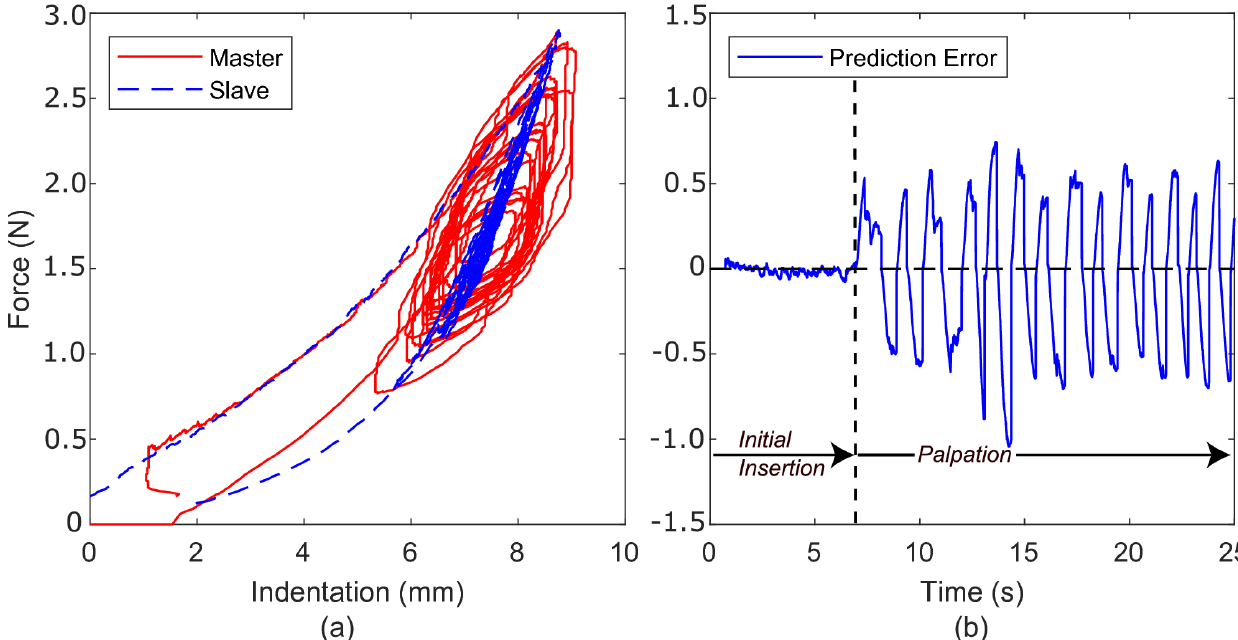
Figure 8. ( a ) Force-indentation profile using the original spring-based adaptor to moderate the feedback force to the master. ( b ) Prediction error during